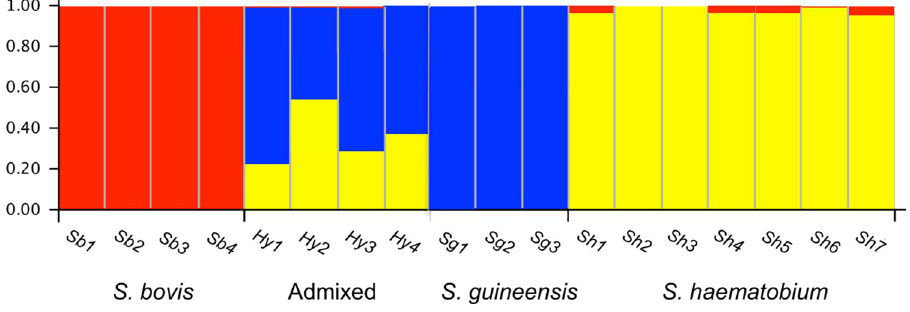
Fig 2. Output from STRUCTURE analysis using K = 3, see S3 Fig for comparisons with K = 1–10. Each bar represents an individual and the relative proportion of its genotype belonging to each genetic cluster. The analysis was performed excluding differentially fixed SNPs, outlier loci and adjusted for computational power. Total number of loci used in the analysis was